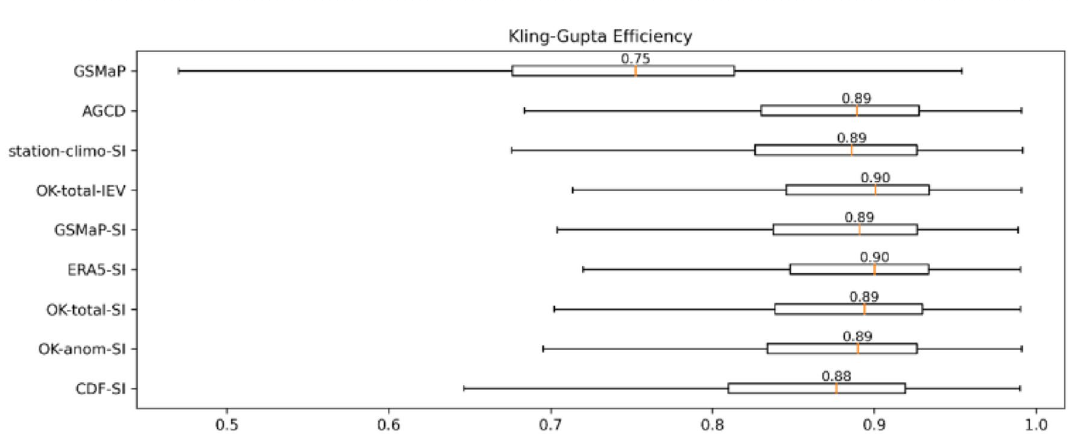
Figure 4. Boxplot of Kling-Gupta Efficiency (KGE) from MSWEP validation. A value of unity is ideal. The boxes indicate the interquartile range (IQR), the whiskers extend out to the non-outlier minimum